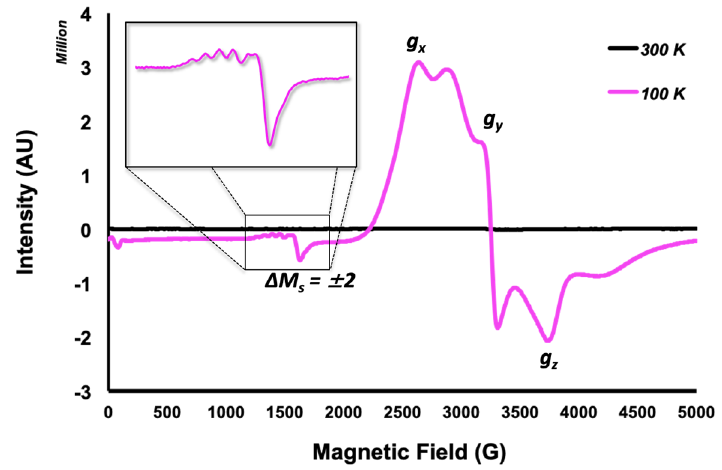
Figure 4. Variable temperature X-band EPR spectra at 300 K (black) and 100 K (purple) of complex 2 recorded in toluene (in solution and frozen glass, respectively).